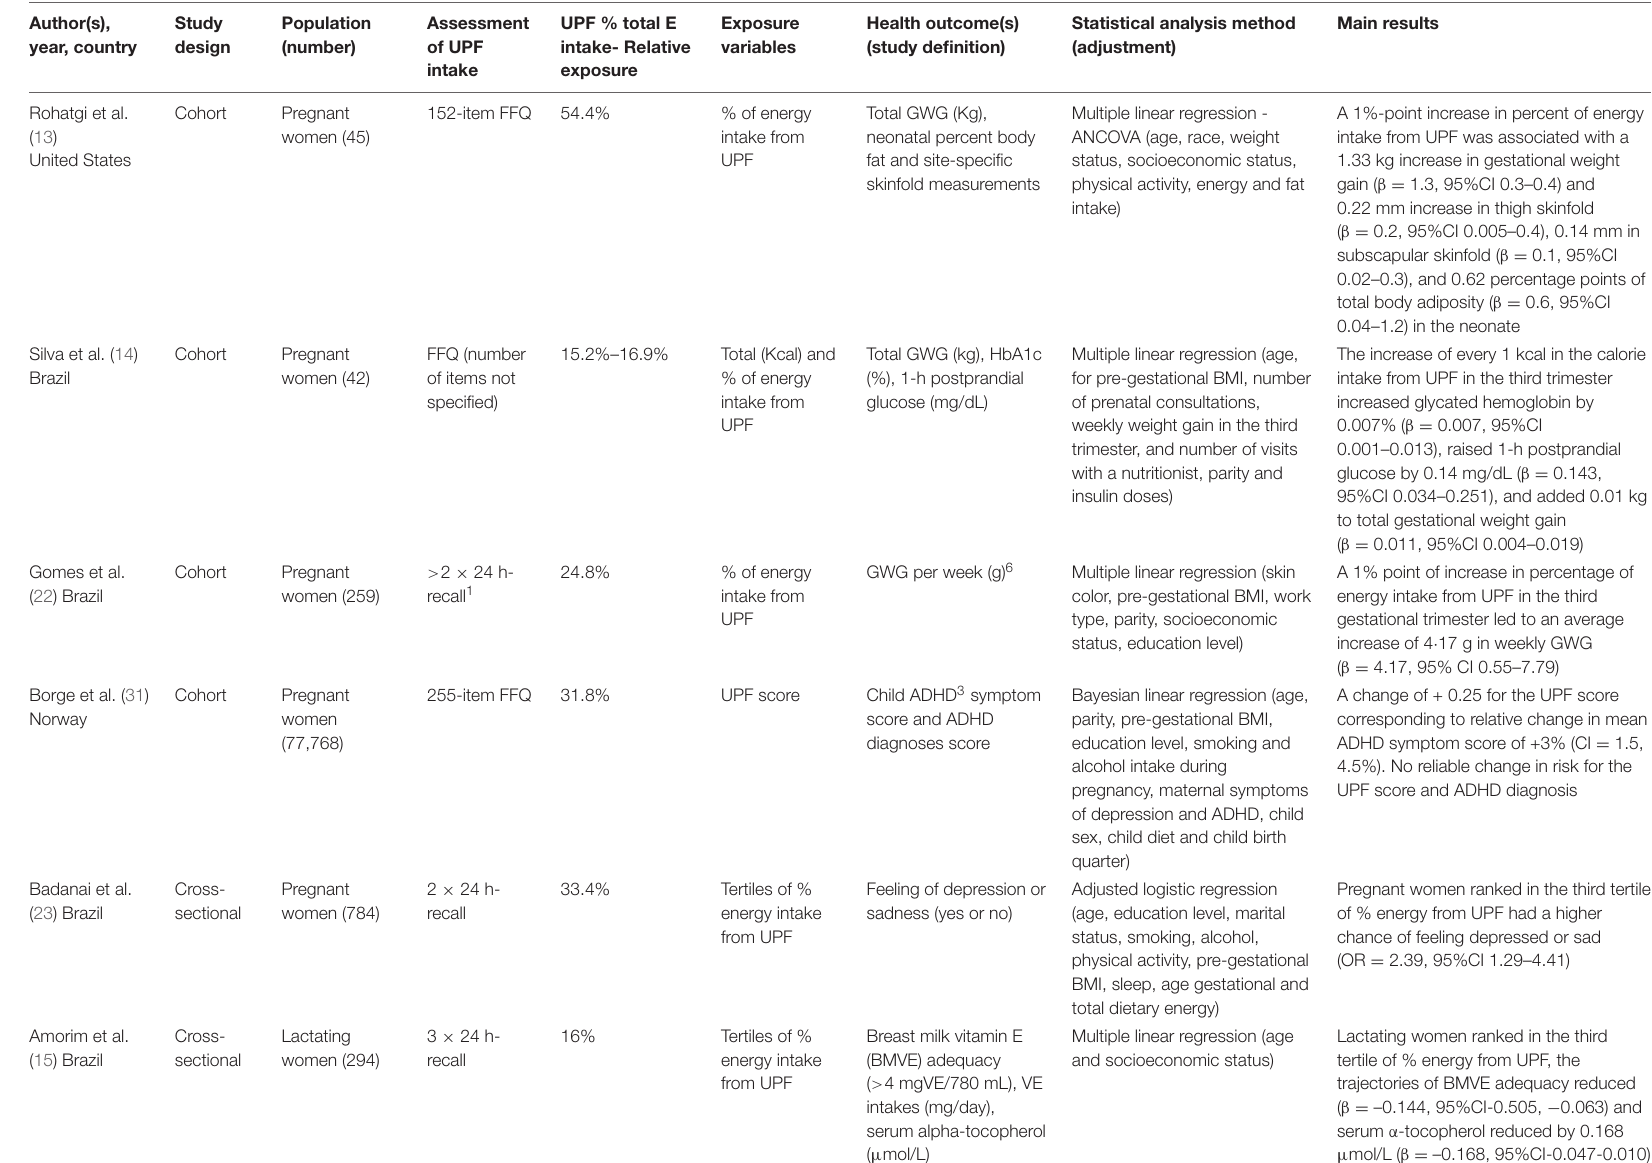
TABLE 2 | Characteristics of included studies ( n =